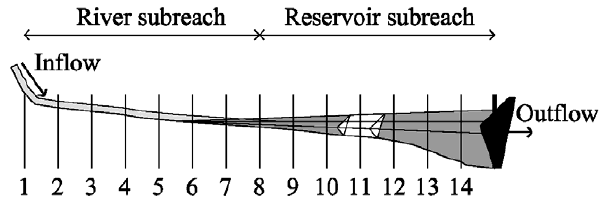
Fig. 3. Bed elevation change of a reservoir: (a) plan view along longitudinal profile: for each cross-section the volume of sediments Table 7: Comparison of observed and modelled transient riverbed storage data with sediment to be deposited is distributed over a stretch L 0 with a width of half fluxes of the Isabena and Villacarli catchments 7 the distance to the next upstream (CS 6 with a width of L 6 ) and Landscape compartment Transport or storage process downstream (CS 8 with a width of L 8 ) cross-section, (b) deposition along an individual cross-section of the reservoir (for variables see Eq.